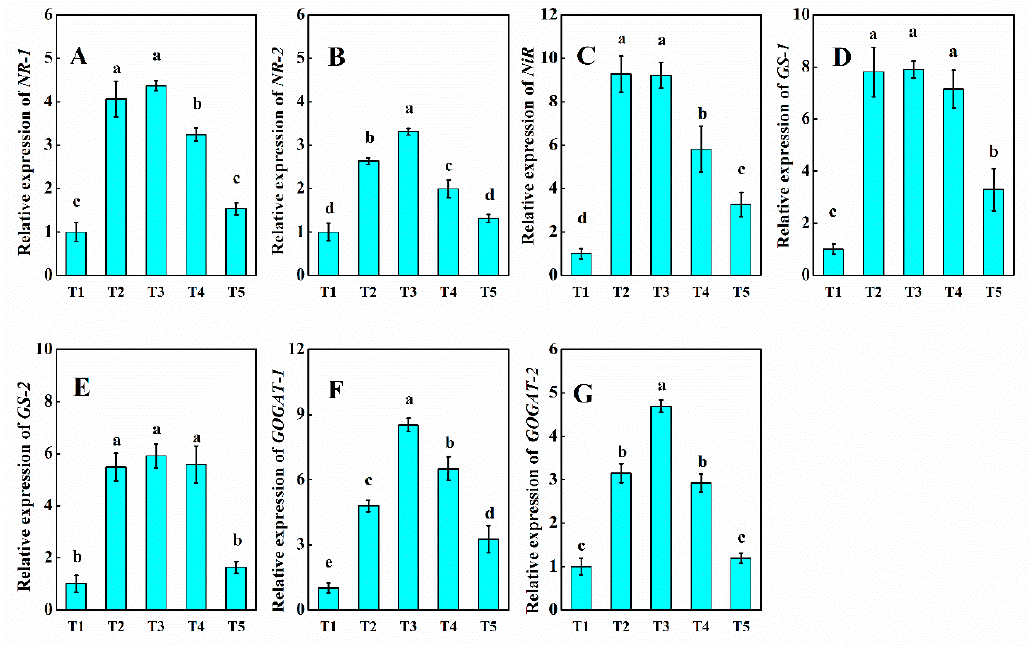
Figure 6. The relative expression of NR-1 ( A ), NR-2 ( B ), NiR ( C ), GS-1 ( D ), GS-2 ( E ), GOGAT-1 ( F ), and GOGAT-2 ( G ) genes involved in nitrogen metabolism in pepper leaves 60 days after transplantation at the five different NH 4+ :NO 3 − ratios (T1, T2, … T5). Vertical bars represent mean ± SE from three independent replicates and the different letters denote significant differences ( p < 0.05) among treatments. Abbreviations: nitrate reductase ( NR ); nitrite reductase ( NiR ); Glutamine synthetase ( GS ); glutamate synthases ( GOGAT ).